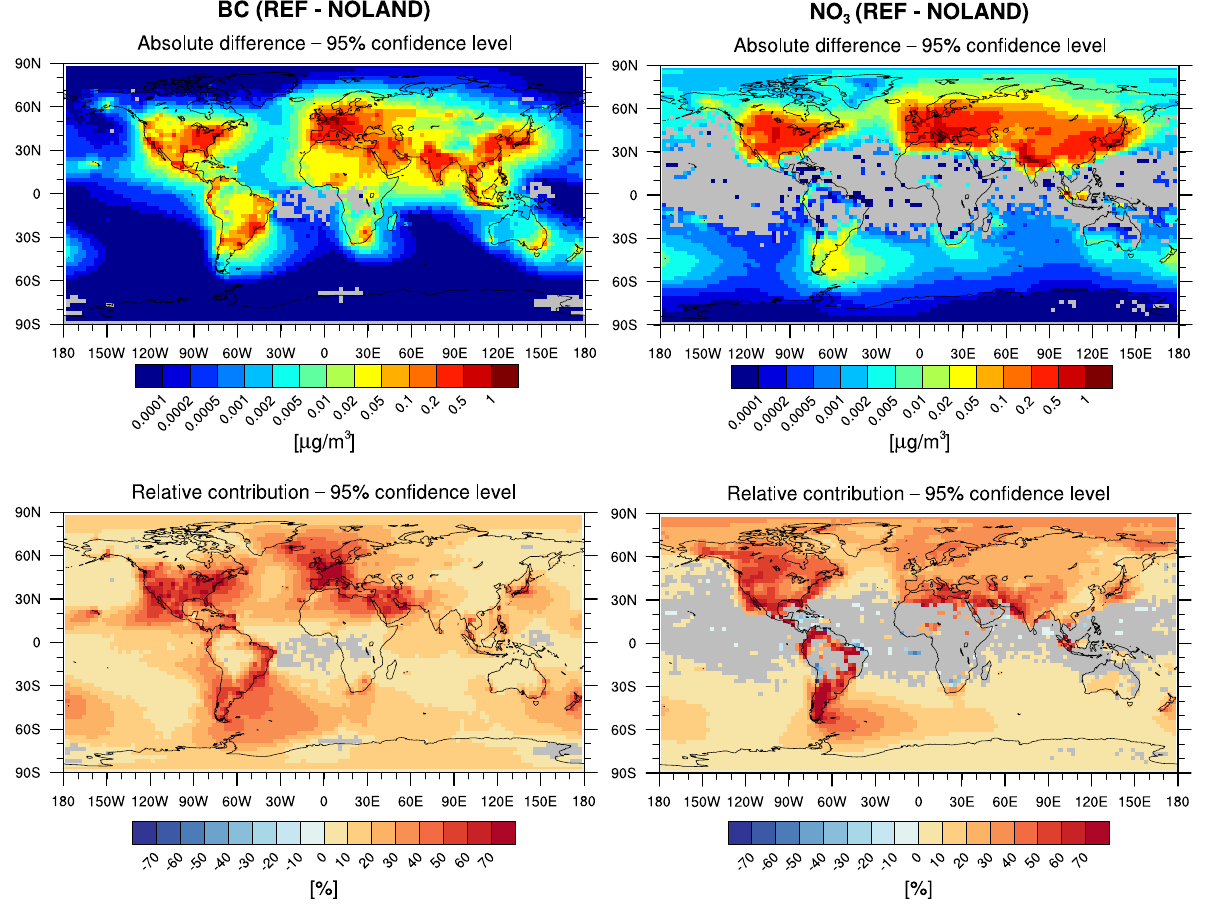
Fig. 4. Multi-year average (1996–2005) of the absolute (top) and the relative effect (bottom) of land transport on BC (left) and aerosol nitrate (NO 3 , right) concentrations at the surface. Plotted are the differences between the experiments REF and NOLAND. The relative effect is calculated as the relative contribution (REF–NOLAND)/REF. Grid points where the difference is not statistically significant according to a uni-variate t test (5% error probability) are masked out in